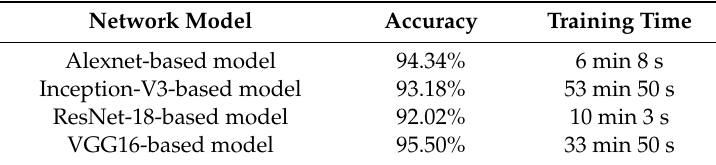
Table 4. Four classification models test result.